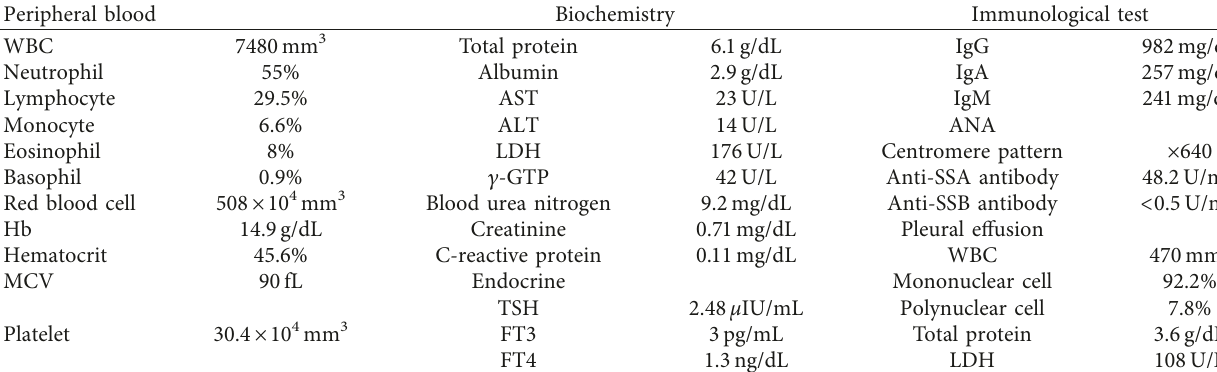
Table 1: Laboratory data on first admission.